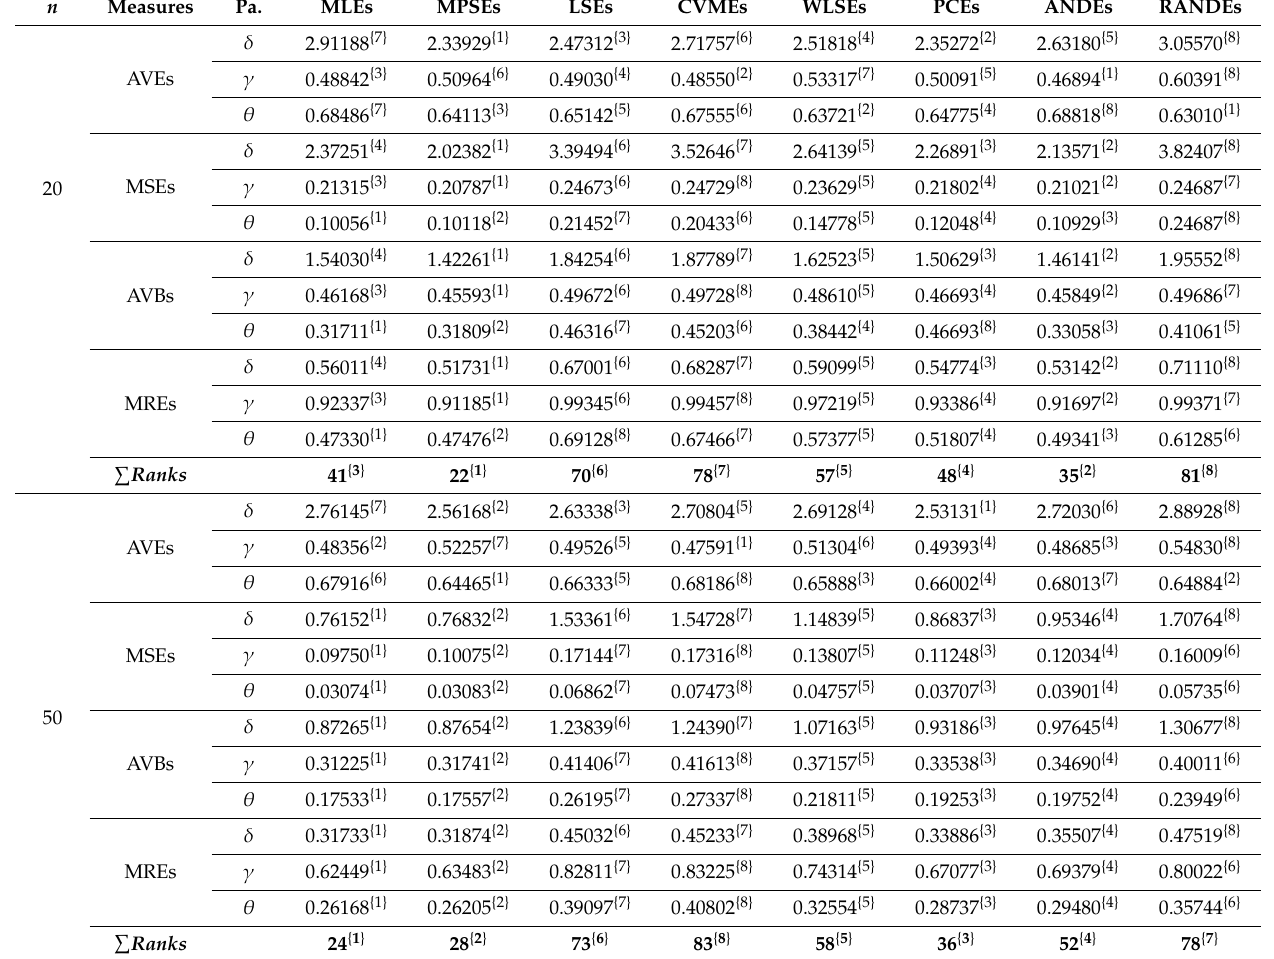
Table A4. Simulation results of several estimation methods for δ = 2.75, γ = 0.50 and θ =